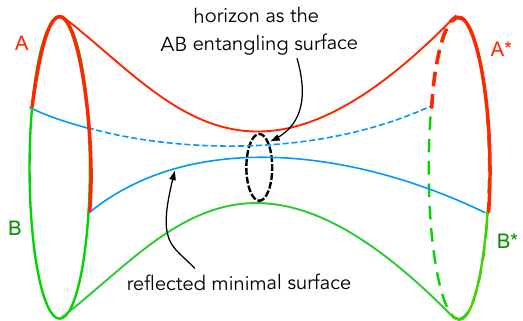
Figure 1 . When AB is the full CFT Hilbert space, the Gibbs state is canonically purified by a thermofield double state in H L ⊗ H R , which is dual to a two-sided Schwarzschild black hole geometry. The horizon is the entangling surface for AB . For this bipartition A : B of the left CFT, the minimal cross-section of its entanglement wedge is 1 / 2 the area of RT surface (shown in blue) for AA ? , that passes through the horizon. We will generalize this picture to other regions AB and states in holographic